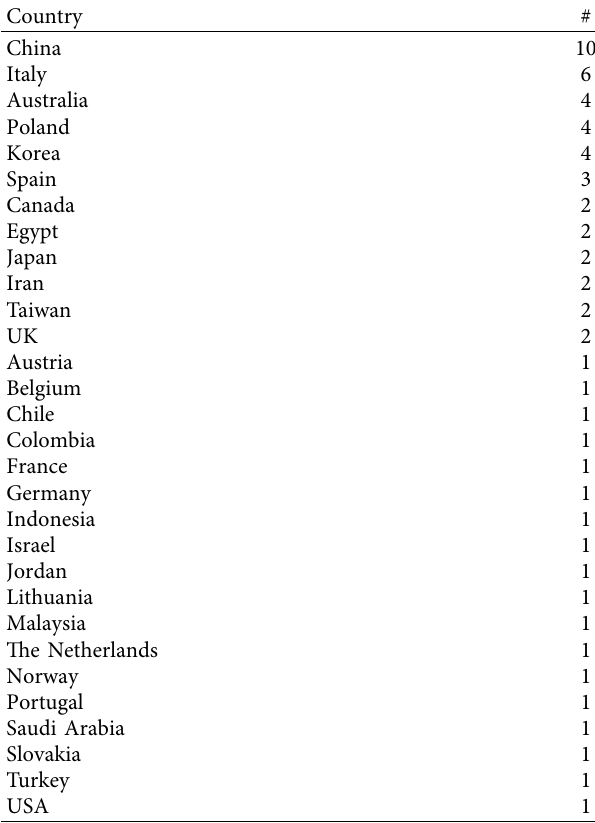
Table 7: Green roof research by country from 2006 to